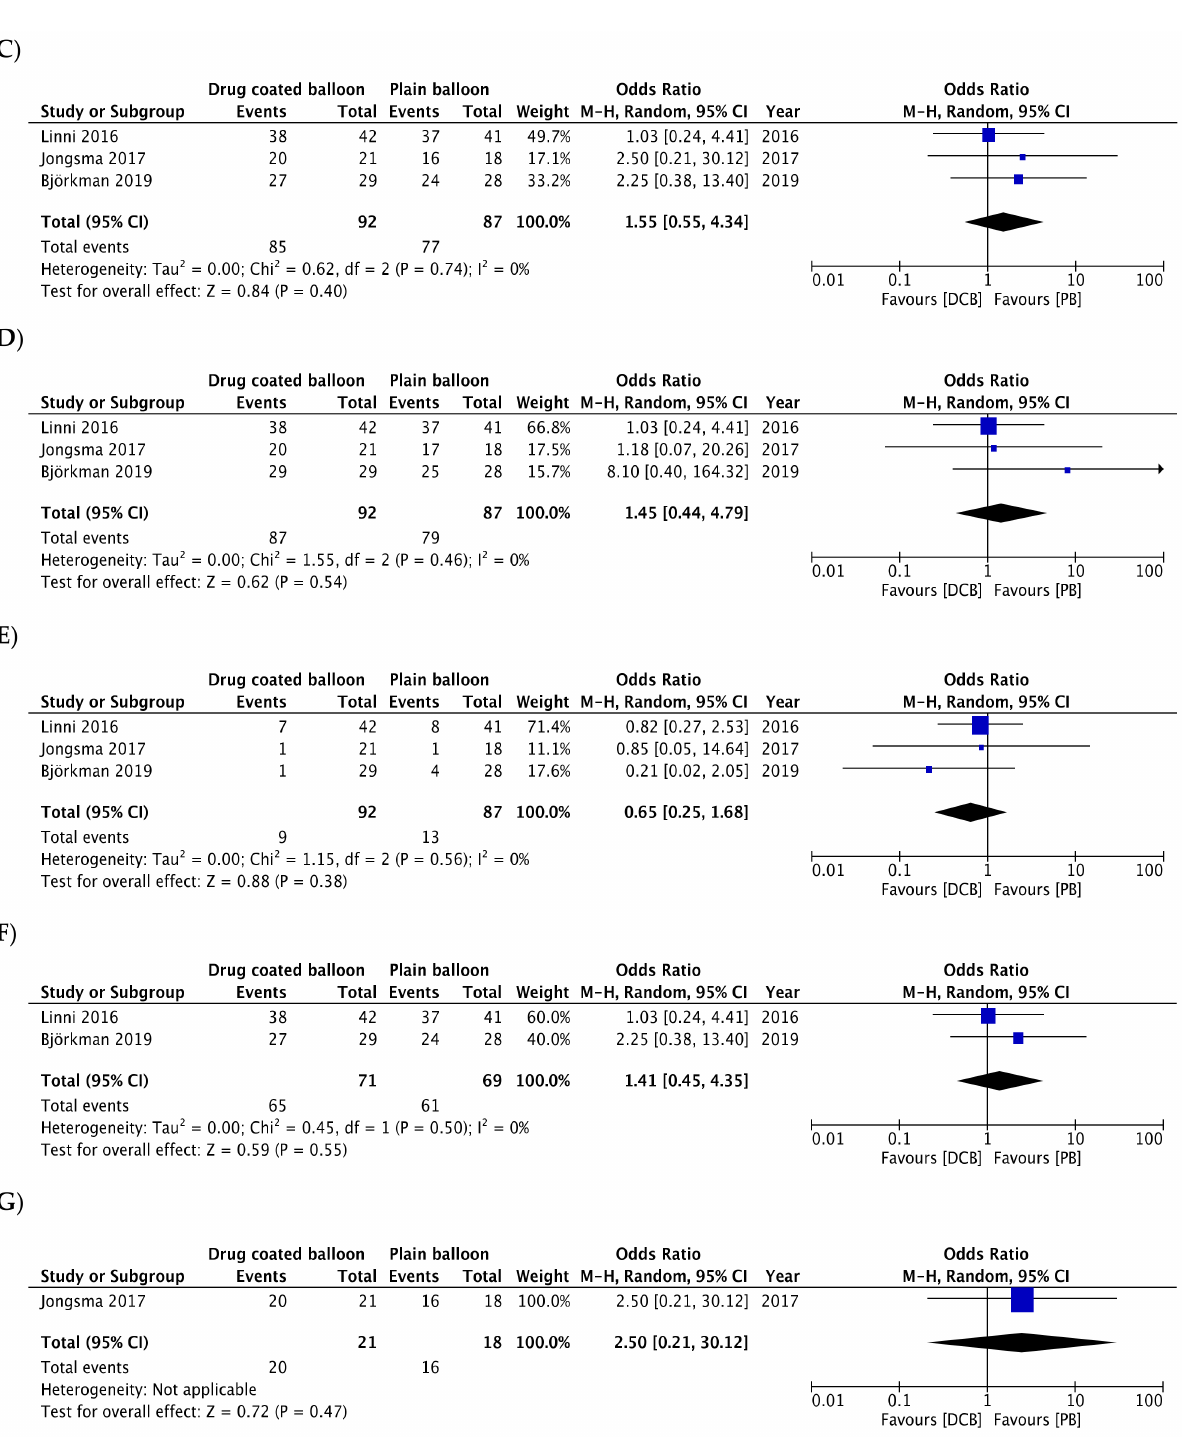
Figure 3. Forest plots of the meta-analysis results of drug-coated balloons (DCB) vs. plain balloons (PB). Angioplasty in studies. ( A ). Target lesion vascularization. ( B ). One-year primary patency. ( C ). One-year assisted primary patency. ( D ). One-year secondary patency. ( E ). Graft occlusion. ( F , G ). Subgroup analysis of one-year assisted primary patency according to DCB device. ( F ). In.Pact. ( G ). Passeo-18 Lux. M-H, Mantel-Haenszel; CI, confidence interval; I2, study heterogeneity; Z, Z -score test statistic